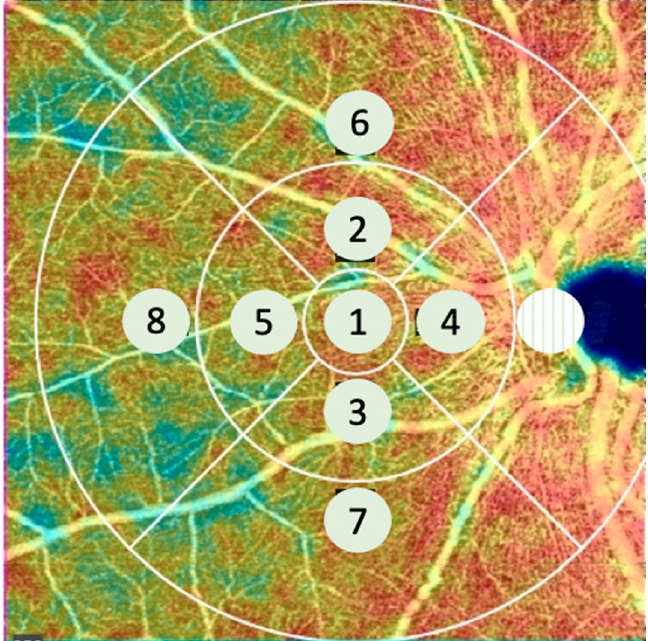
Figure 2. Example of a left eye. The ETDRS (Early Treatment of Diabetic Retinopathy Study) grid was placed nasally using the optic nerve head as a marker. Zone 4 was the most adjacent to the optic nerve head.